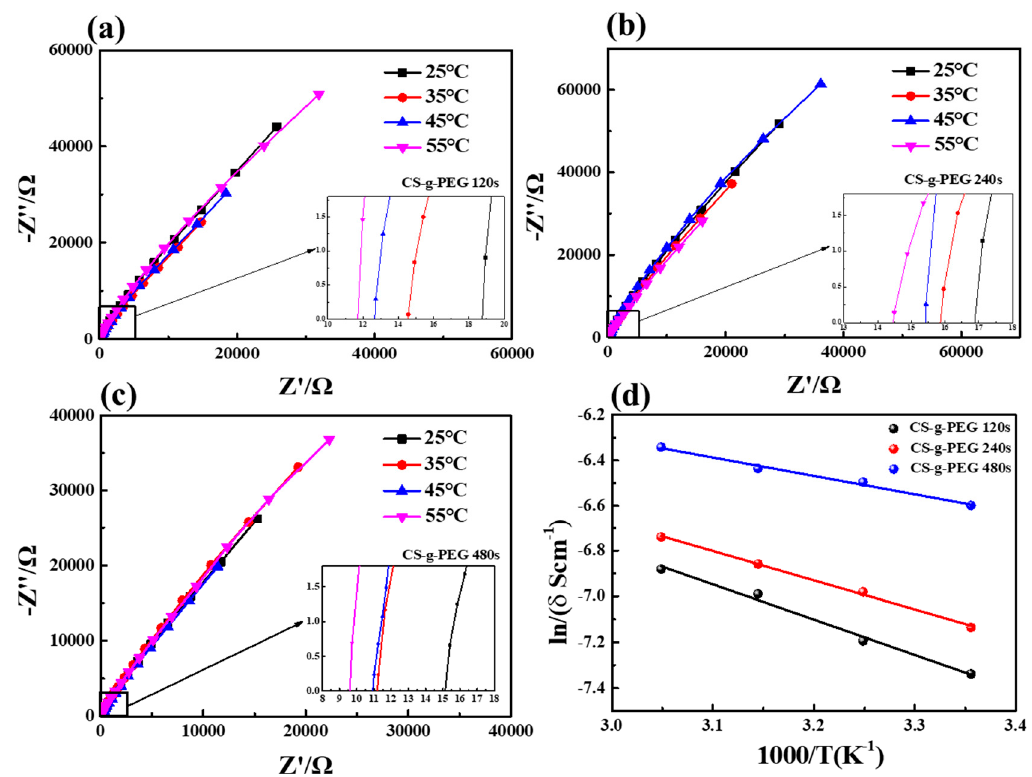
Figure 6. Impedance plots of ACMC GPE membranes at different temperatures: ( a ) CS-g-PEG-120,